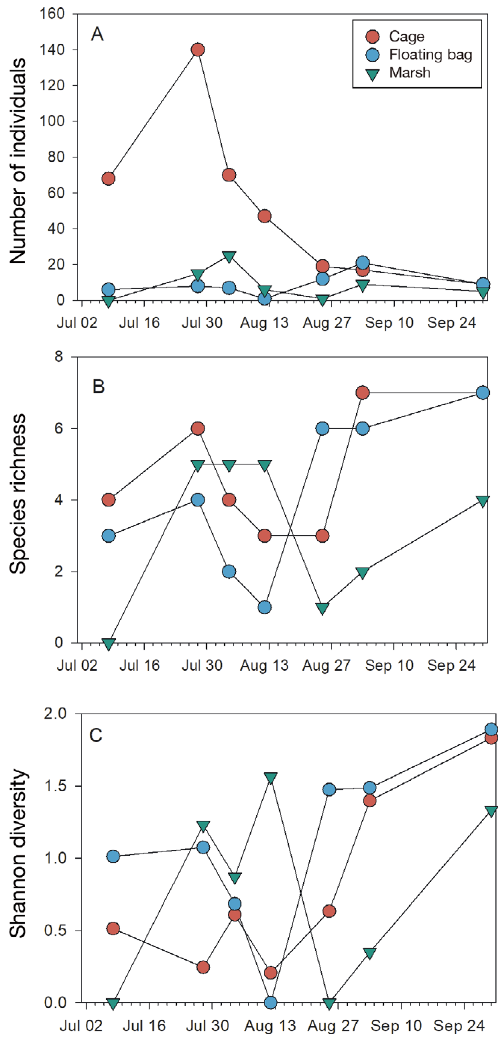
Fig. 2. (A) Total number of individuals (sum of MaxN across all species, where MaxN is defined as the maximum number of individuals of a given species present within each 80 min segment of video). (B) Species richness (total number of species observed). (C) Shannon diversity index for the 3 habitat types over the 7 dates during which video